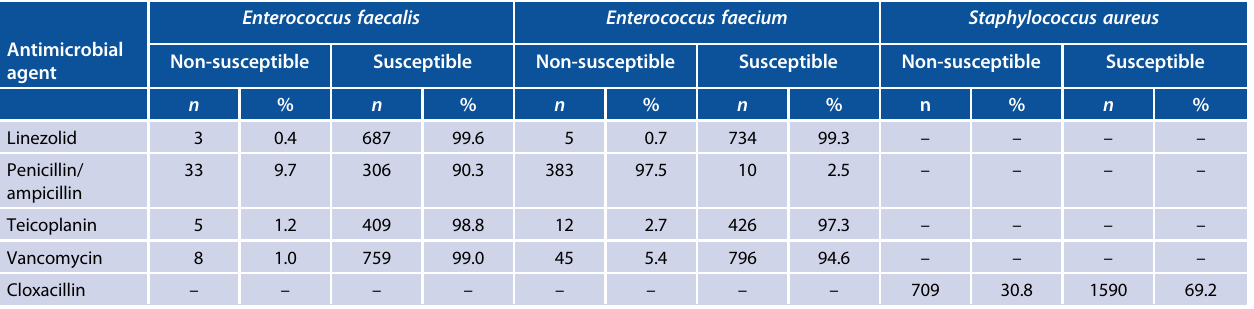
Antimicrobial agent